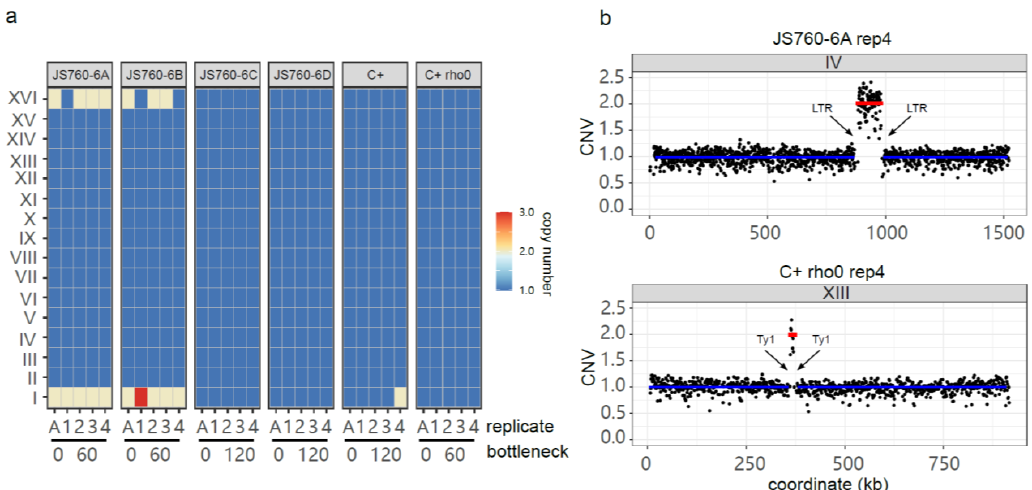
Figure 6. Aneuploidies and segmental copy number variants. ( a ) Chromosomal copy number changes of six ancestor stains (denoted with “A”) and their four MAL replicates. ( b ) Two cases of segmental duplication with repeat-associated breakpoints (indicated with arrows). The blue lines represent normal copy number while the red lines represent segmental duplication. The genotypes of the six strains are as follows: JS760-6A ( MRPL25 + atp3 G348T ), JS760-6B ( mrpl25 Δ ATP3 + ), JS760-6C ( MRPL25 + ATP3 + ), JS760-6D ( mrpl25 Δ atp3 G348T ), C+ (positive control), C+ rho0 (negative control).